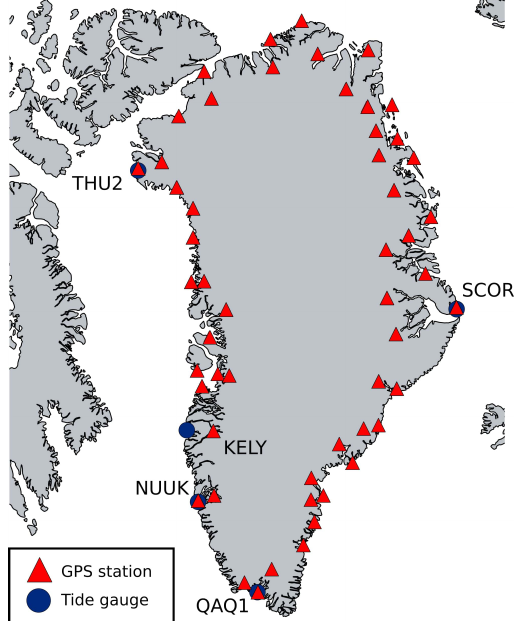
Figure 5. Map of Greenland with indication of GNET GNSS stations and tide gauges with data overlapping the nearest GPS